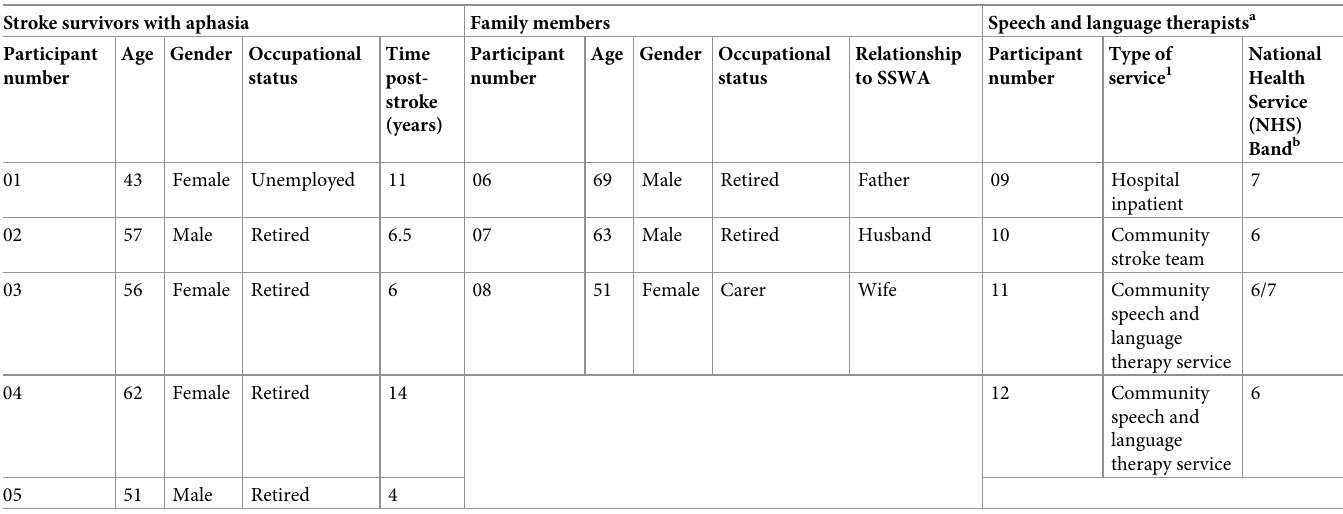
Table 2. Participant characteristics.